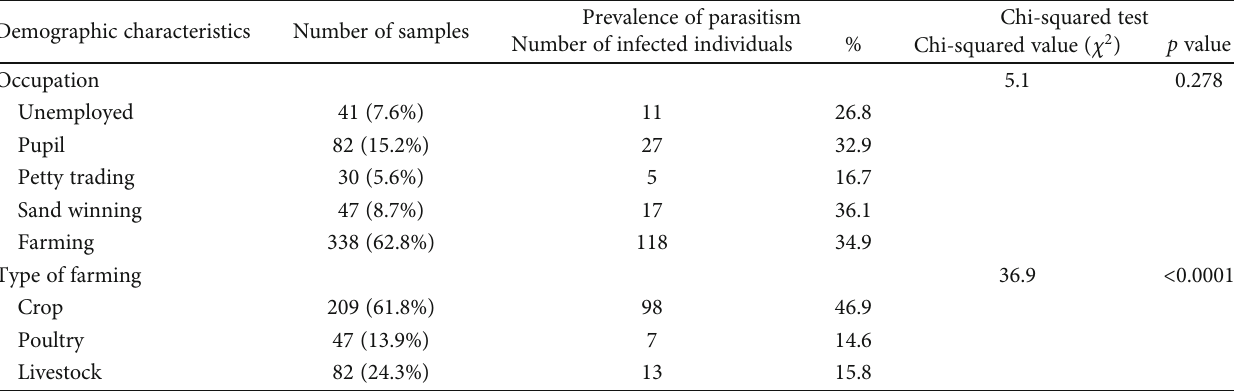
(Figure 1). Prevalence of parasitism among males